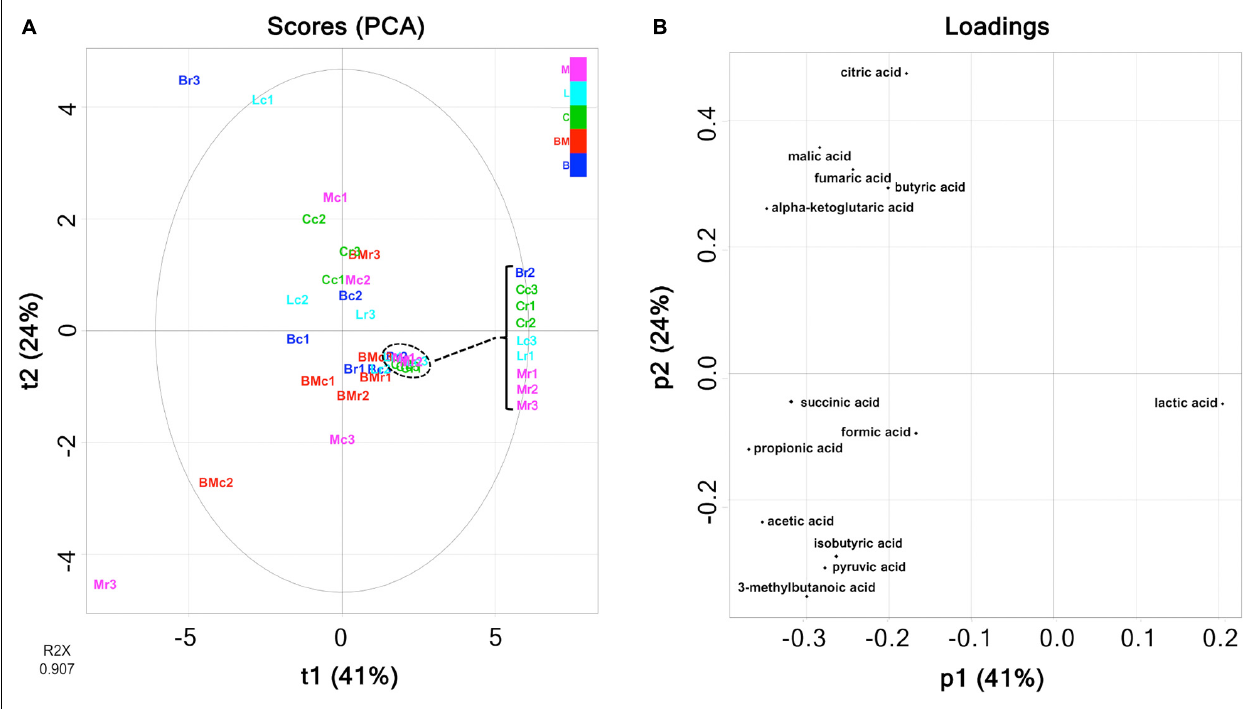
FIGURE 4 | Principal component analysis (PCA) on the abundance of organic acids in 30 cheese samples. (A) Score plot. (B) Loading plot. Bc, Brie de Meaux core; Br, Brie de Meaux rind; BMc, Brie de Melun core; BMr, Brie de Melun rind; Cc, Coulommiers core; Cr, Coulommiers rind; Lc, Langres core; Lr, Langres rind; Mc, Maroilles core; Mr, Maroilles